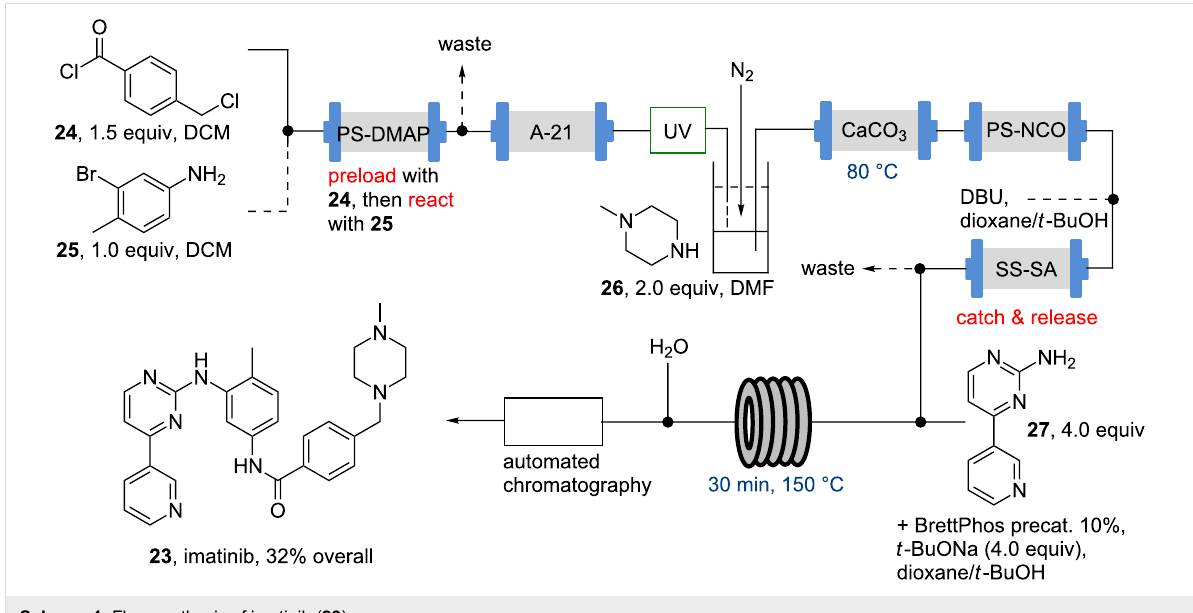
Scheme 4: Flow synthesis of imatinib ( 23 ).